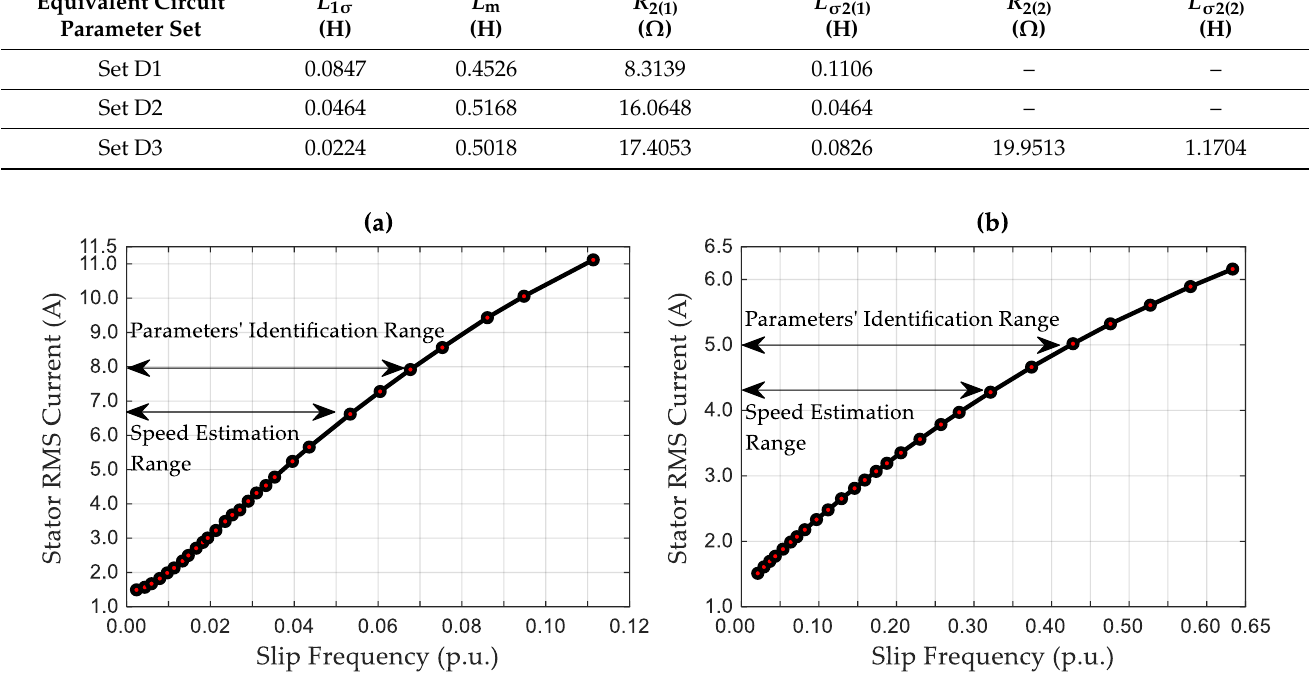
Figure A1. The current slip characteristics of the tested IMs: ( a ) the CR IM; ( b ) the SR IM.